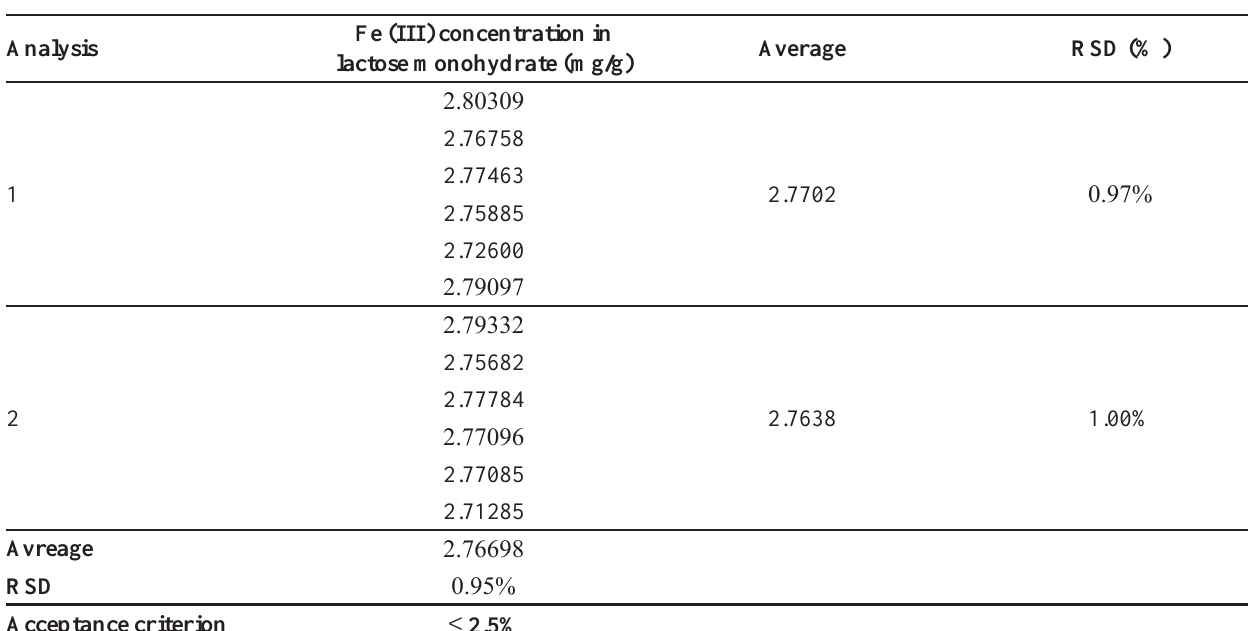
TABLE III - Range determined according to the linearity and accuracy (nominal concentration of Fe (III) =11.2 µg/mL) TABLE IV - Results of the repeatability of the system Sample TABLE V - Results of the repeatability of the procedure Analysis